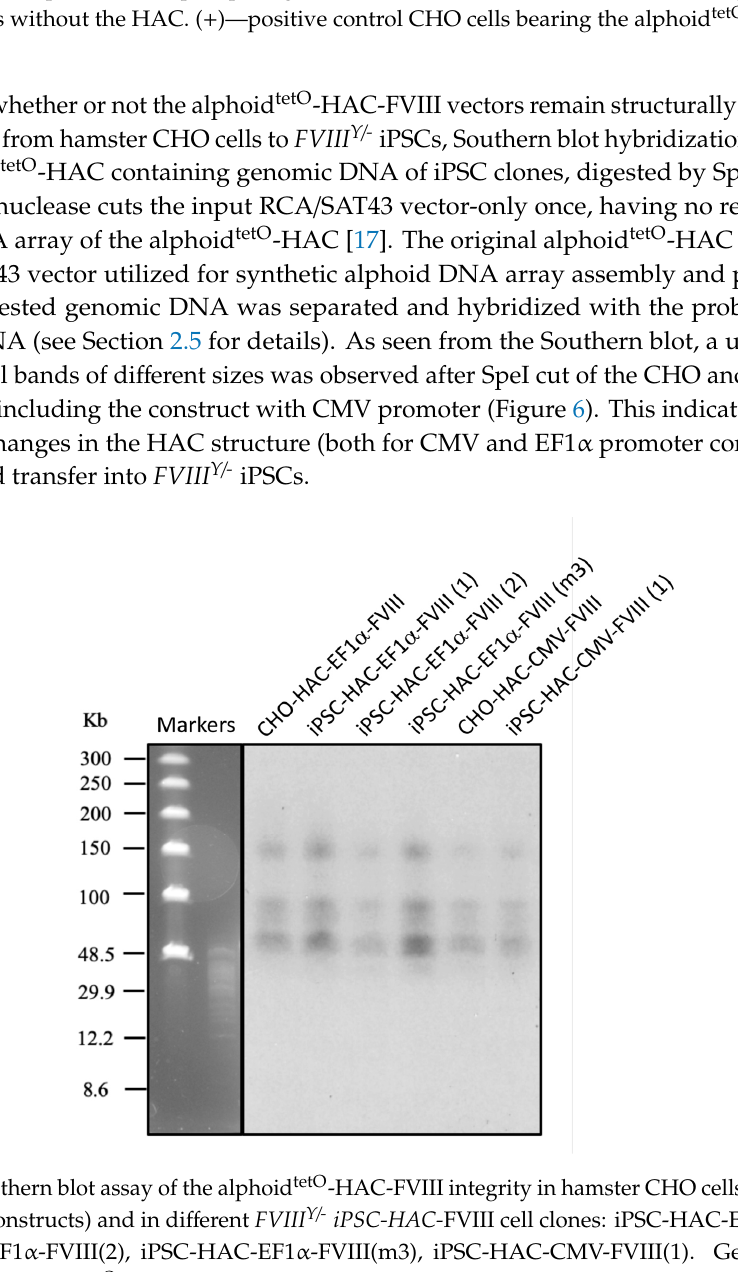
Figure 5. Western blot analysis of FVIII protein expression in the FVIII Y/ ‐ iPSC ‐ HAC ‐ FVIII clone 1 and clone 2 at the 5 th (p5) and 10 th (p10) passages after cultivation with blasticidin. (–)—a negative control FVIII Y/ ‐ iPSCs without the HAC. (+)—positive control CHO cells bearing the alphoid tetO ‐ HAC ‐ FVIII (clone 2).